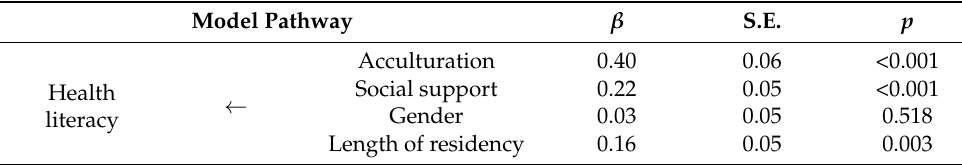
Table 3. Path estimates and significance of the